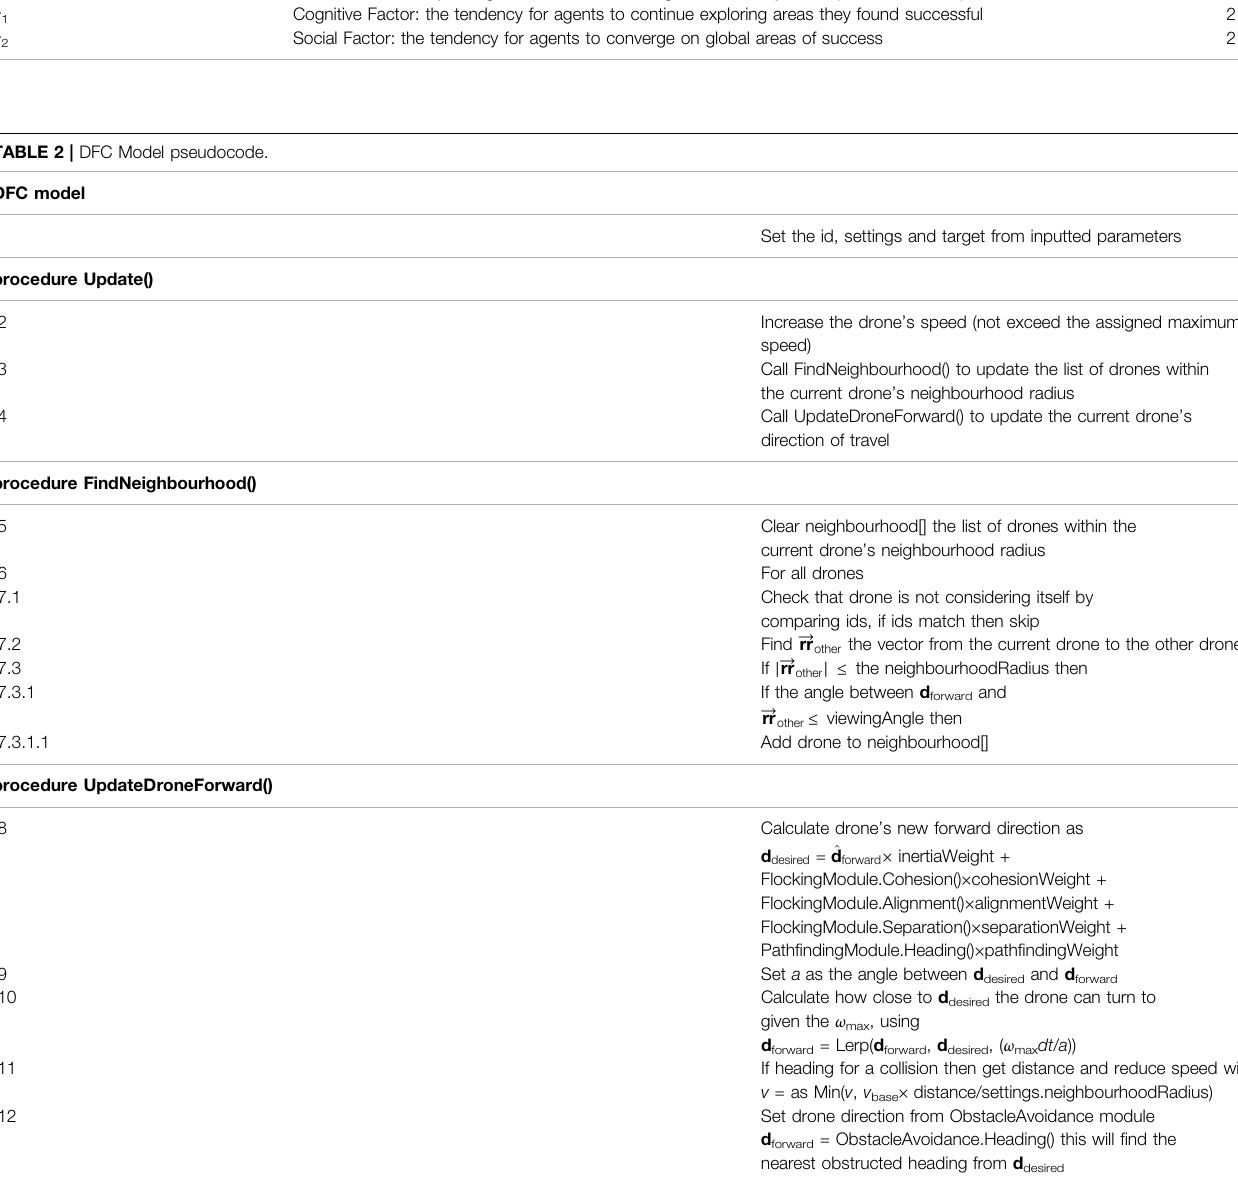
TABLE 1 | PSOP algorithm constants. Constant De fi nition Value w Cognitive Factor: the tendency for agents to continue exploring areas they found successful Social Factor: the tendency for agents to converge on global areas of success